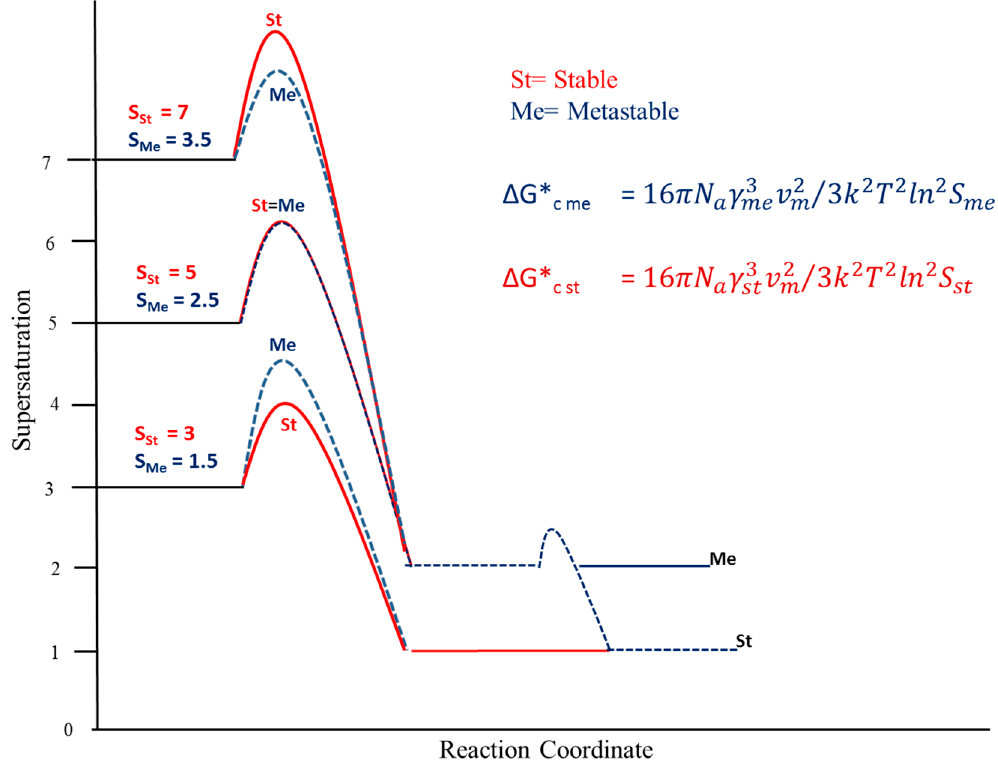
Figure 2. Crystallisation pathway for a polymorph pair at the supersaturations indicated. ( C * me /C * st = 2; γ st / γ me = 1.45; V m = 3.5 × 10 − 28 m 3 molec − 1 ).